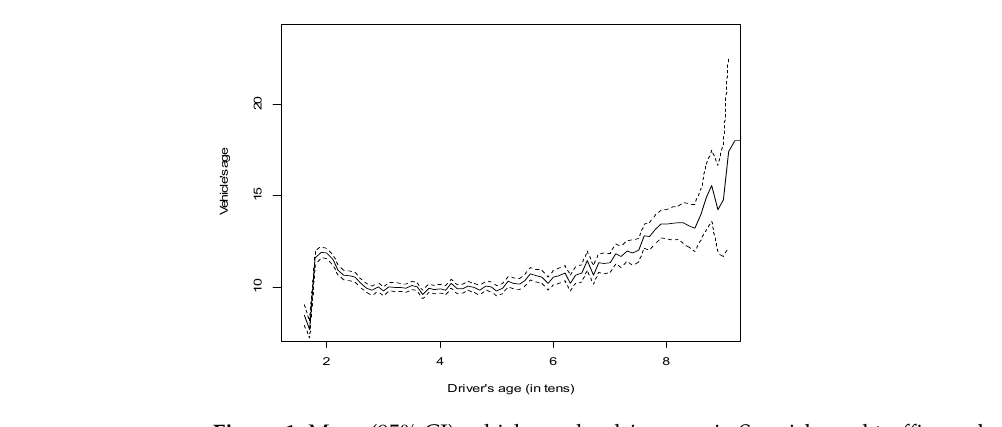
Figure 1. Mean (95% CI) vehicle age by driver age in Spanish road traffic crashes.